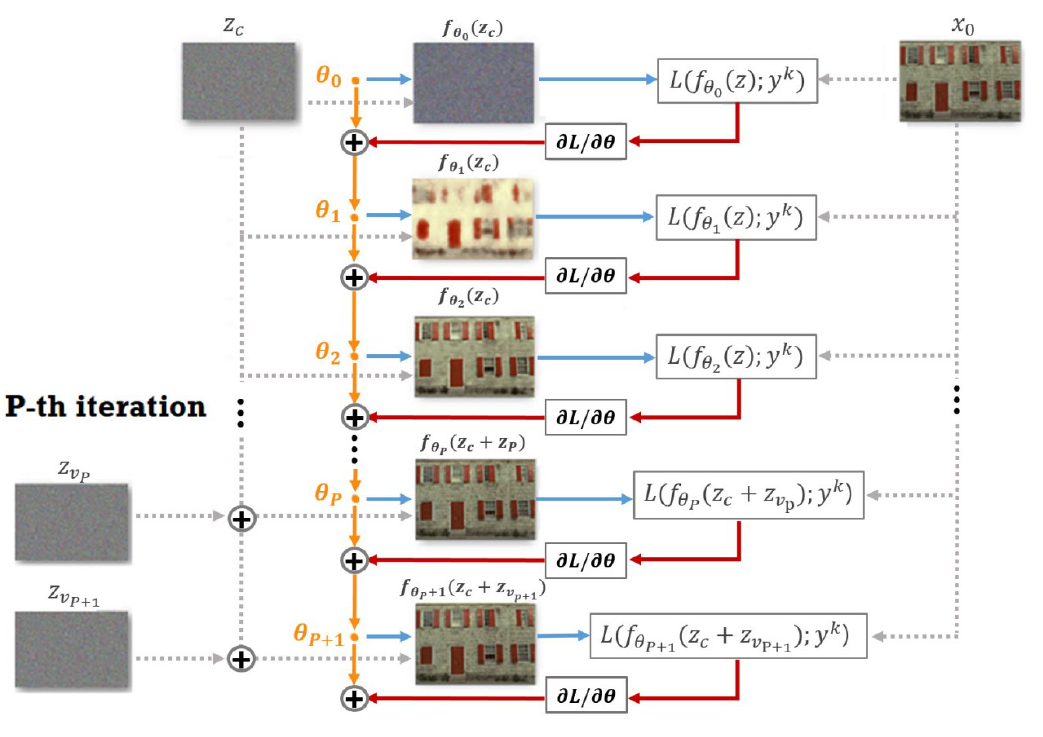
, z v ,... is added after the P P + 1